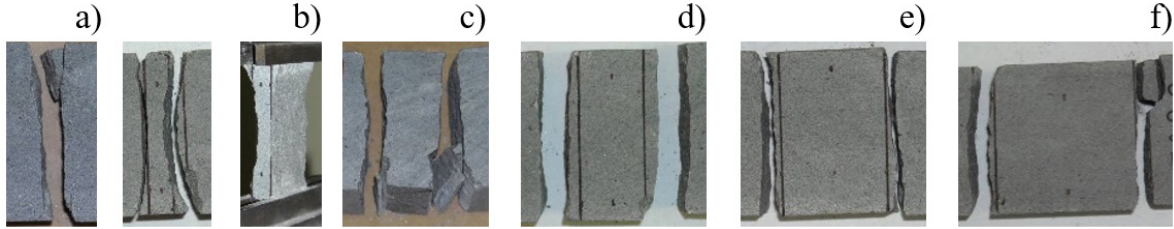
Figure 8: Crushing of “Mucharz” sandstone by a group of four flat coaxially arranged stamps. Sample failure mechanisms for different t/h ratios: a) 0.08; b) 0.23; c) 0.38; d) 0.45; e) 0.72; f)